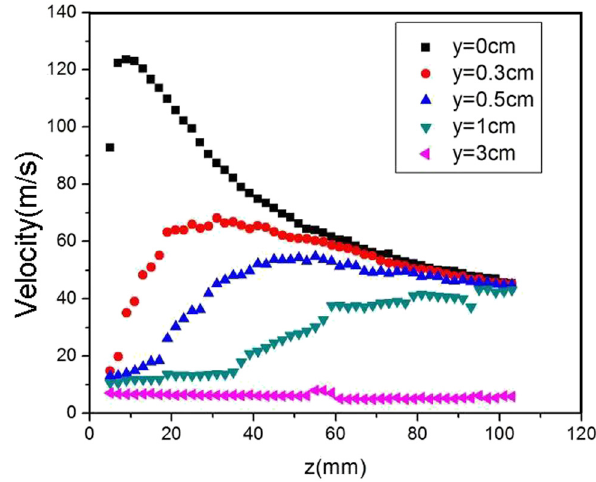
Figure 6: Velocity distribution on di ff erent y - lines.